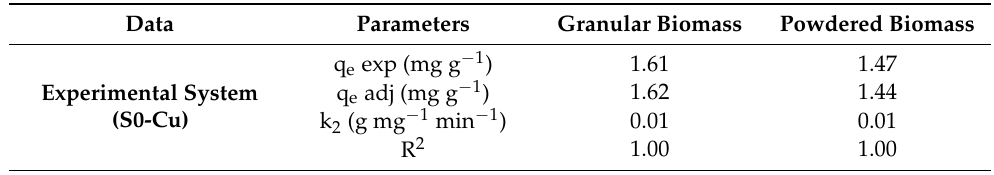
Table 7. Pseudo-second-order model parameters for copper systems: S0-Cu, S1-Cu, S2-Cu, and